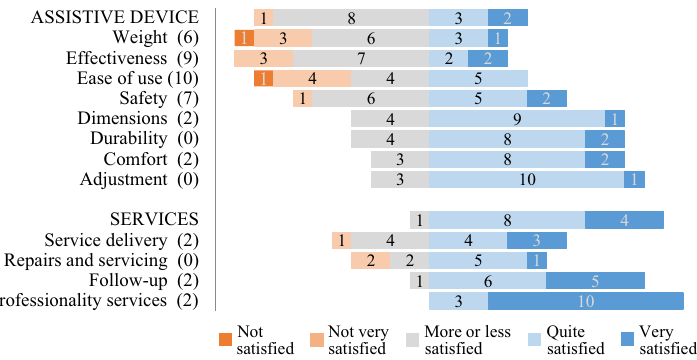
Figure 4. Distribution of the satisfaction scores on the items of the Quebec User Evaluation of Satisfaction with Assistive Technology (D-QUEST). A satisfaction score of ‘more or less satisfied’ or less (D-QUEST ≤ 3) was considered dissatisfied. The numbers in brackets represent how frequent an item was indicated within the top 3 most important items of the D-QUEST by the